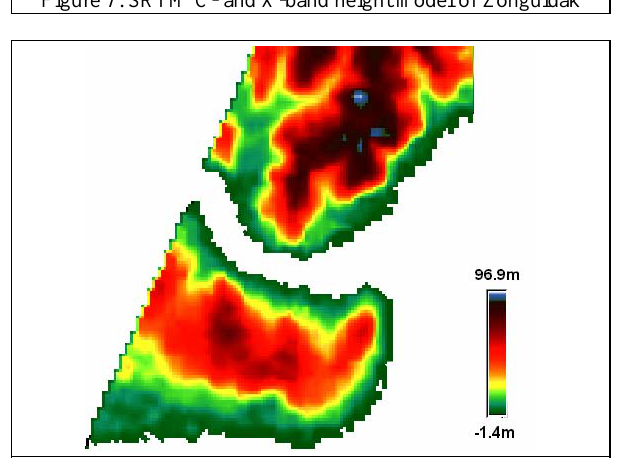
Figure 8. SRTM C-band height model of Istanbul